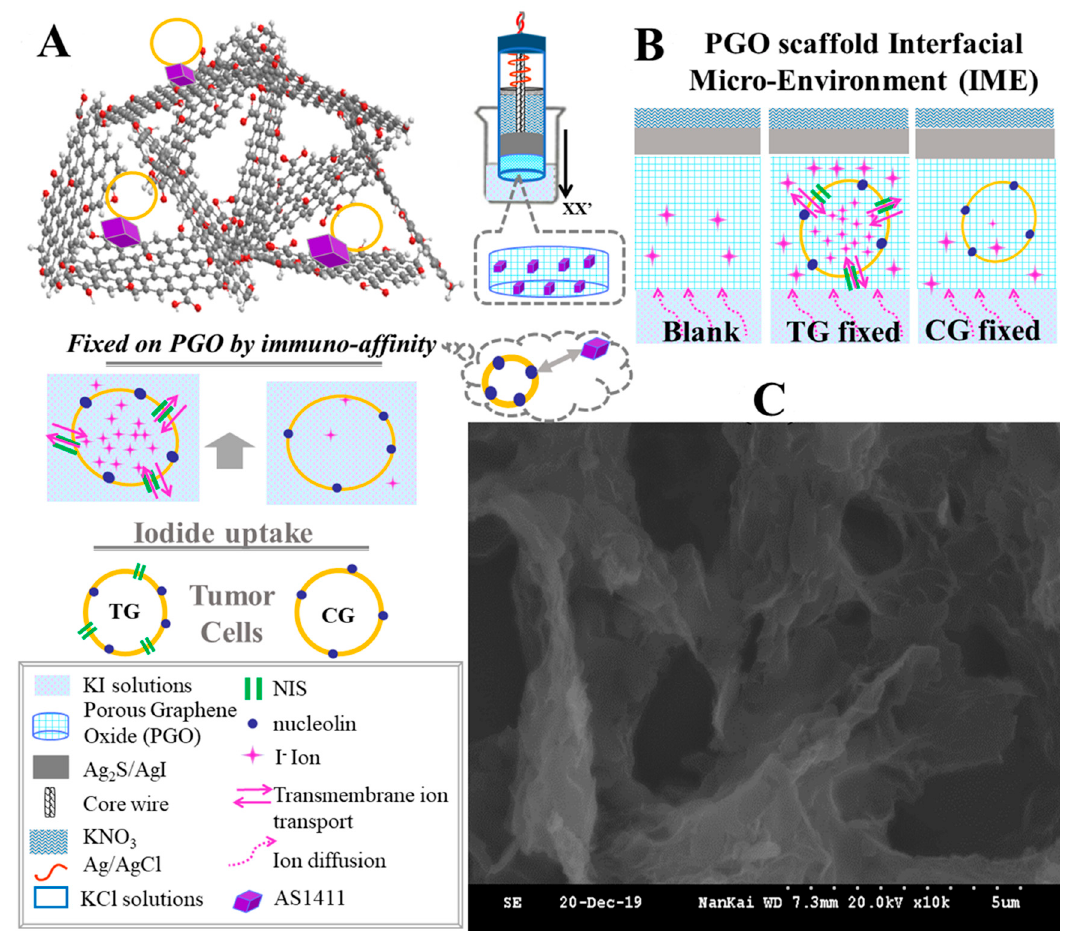
Figure 1. The protocol for observing the across-cytomembrane ion transport induced variations by using PGO decorated I - -ISE. ( A ) Schematic diagram of the experimental procedure, that is: The PGO suspension is drop-coated on the sensing membrane (Ag 2 S/AgI) of ISE, then PGO-ISE is functionalized by AS1411 (AS1411-PGO-ISEs); then the tumor cells are incubated on the AS1411-PGO-ISEs by the immune-affinity between AS1411 and nucleolin surface sites on cells’ membrane. These cells are classified in the test group (TG) and the control group (CG), according to their cytomembranes with and without the NIS expression, respectively. The output voltages (V out ) of ISEs are recorded by immersing them in the similar KI/KNO 3 buffer solutions. ( B ) The sketch maps of the locally amplified interfacial micro-environment (IME) along the xx' direction, before and after the cells immobilizations on the AS1411-PGO-ISEs, which are named as Blank PGO, TG fixed and CG fixed, respectively. ( C ) The scanning electron microscope (SEM) of the PGO layer.